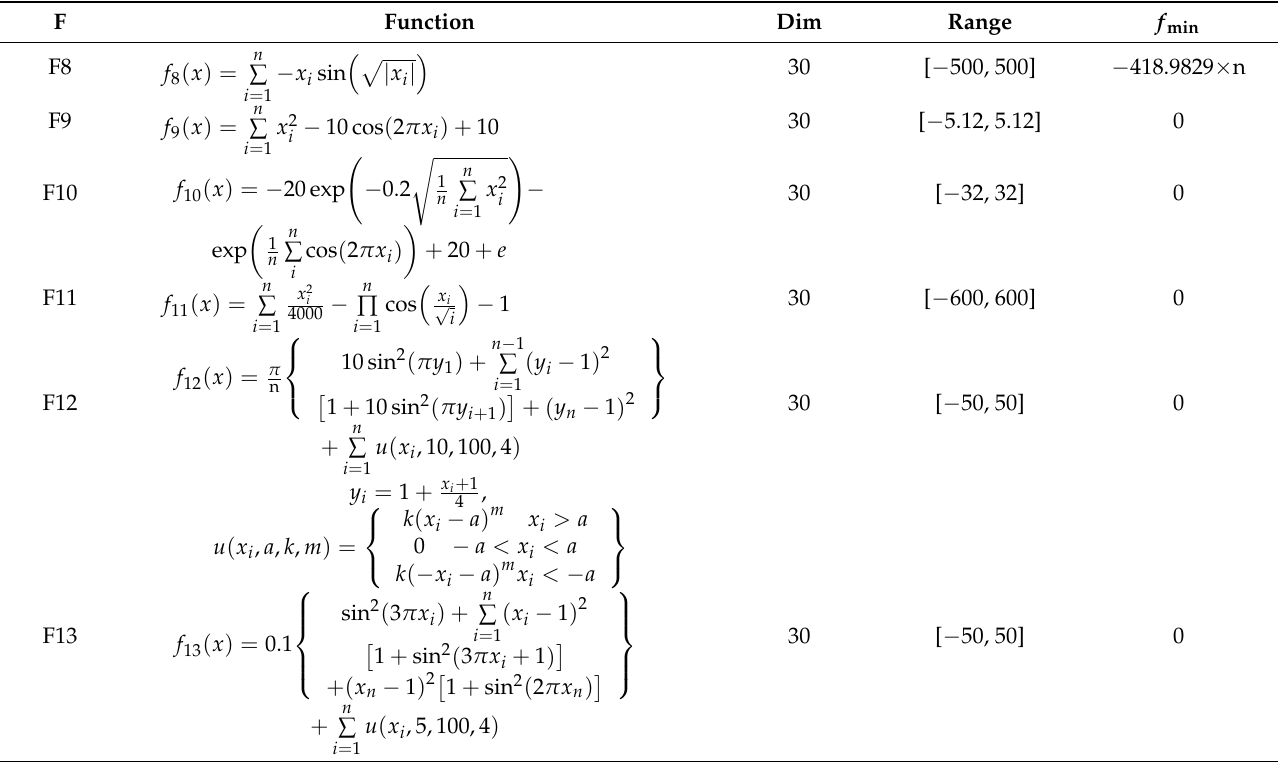
Table 3. Multimodal benchmark